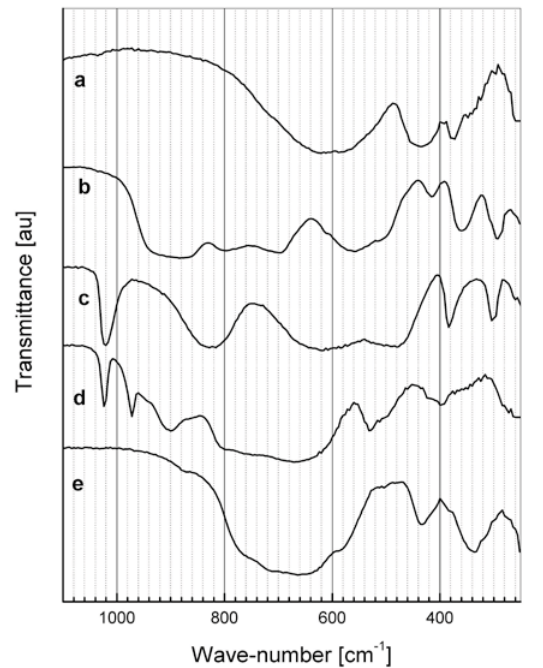
Figure 2. IR spectra of: a) Cd